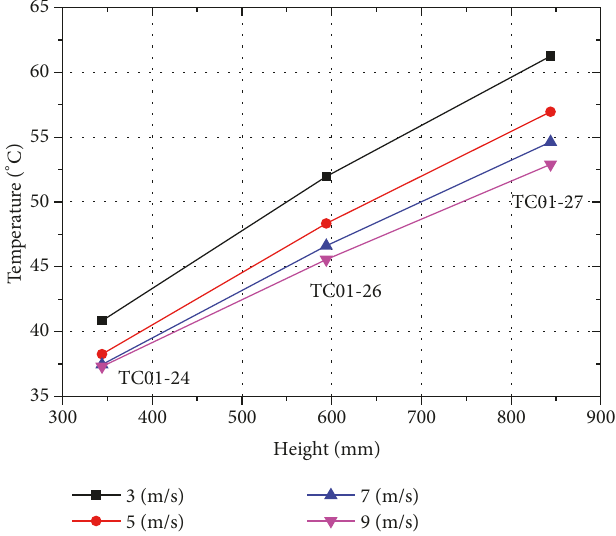
Figure 23: The effect of inlet cooling air velocity on support front plate.